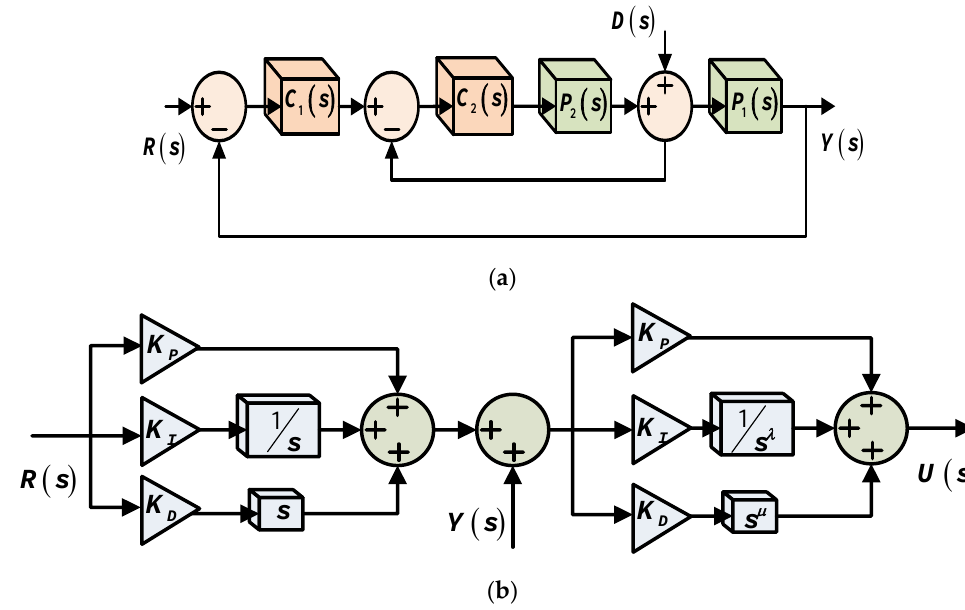
Figure 3. The cascade controller: ( a ) cascade controller mechanism; ( b ) cascade PID-FOPID controller. Area control error ( ACE ) refers to the error reported to the controller. When system loading changes, frequency, and tie-line powers diverge from their nominal or scheduled values, it is undesirable and can lead to power system failure. Continuous monitoring between load demand and generation in AGC reduces ACE . The ACE is a linear combination of frequency and tie-line power variations (Equations (2) and (3)).